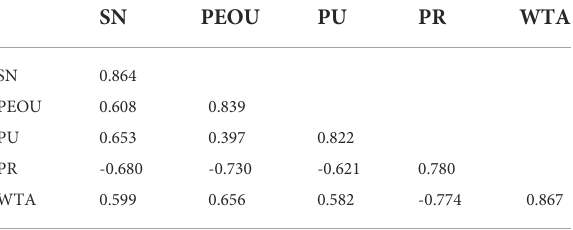
TABLE 3 Results of discriminant validity